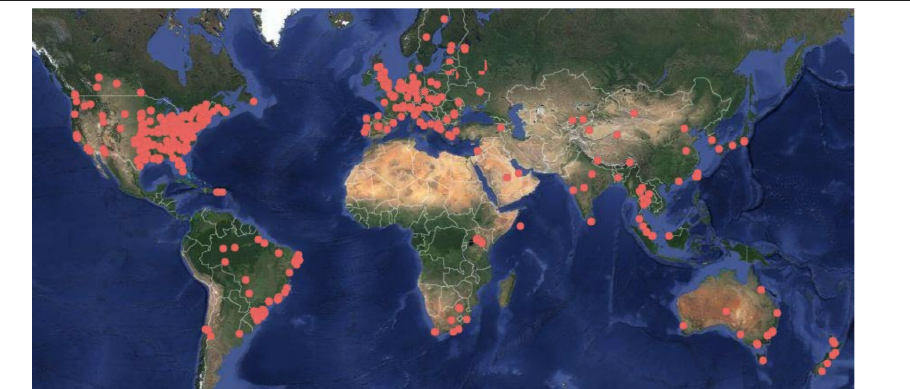
Figure 1: perfSONAR public network; there are currently around 2000 known deployed in- stances with likely an equal number of private deployments, WLCG network is one of the biggest private deployments with over 250 instances connected to LHCOPN /